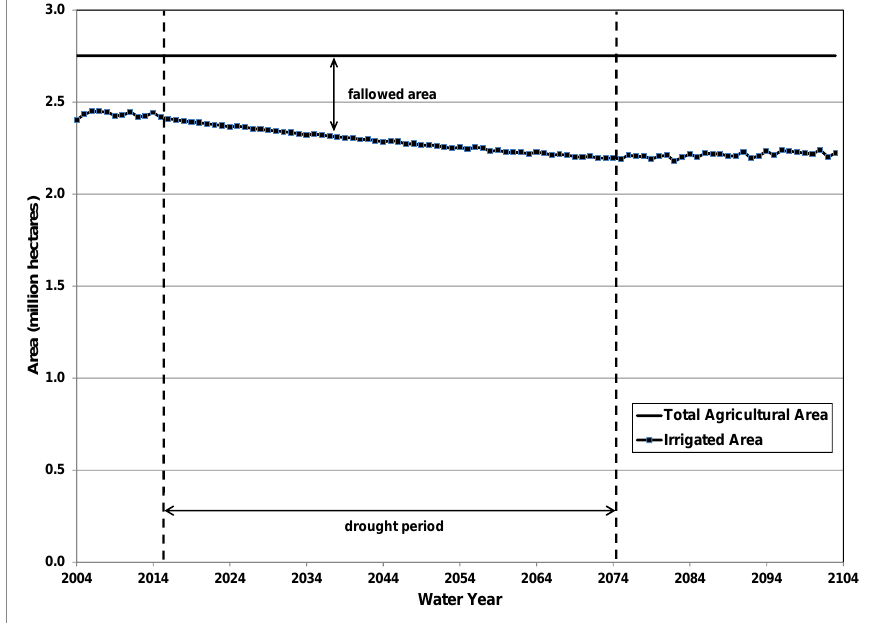
Figure 6. Total irrigated area before, during, and after a 60-year severe drought in the Valley (source: Dale et al. [49].